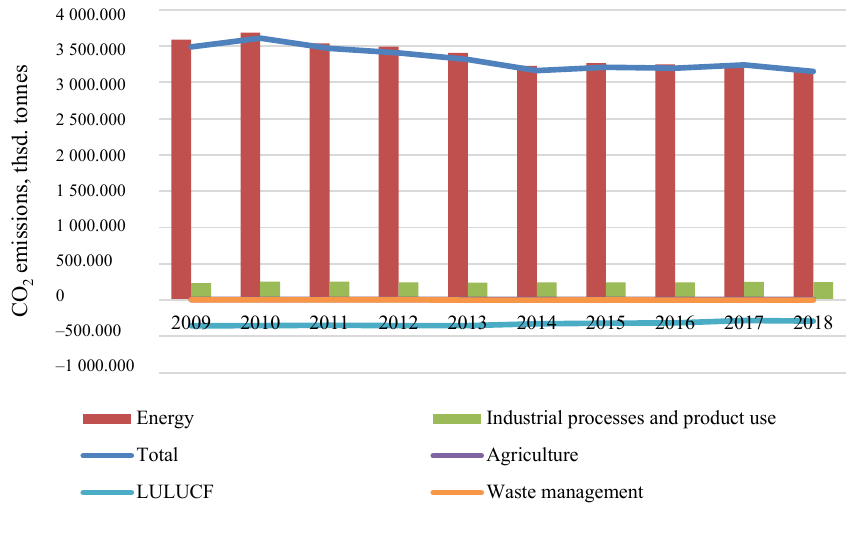
Fig. 1. СО 2 emissions in European Union 2009–2018